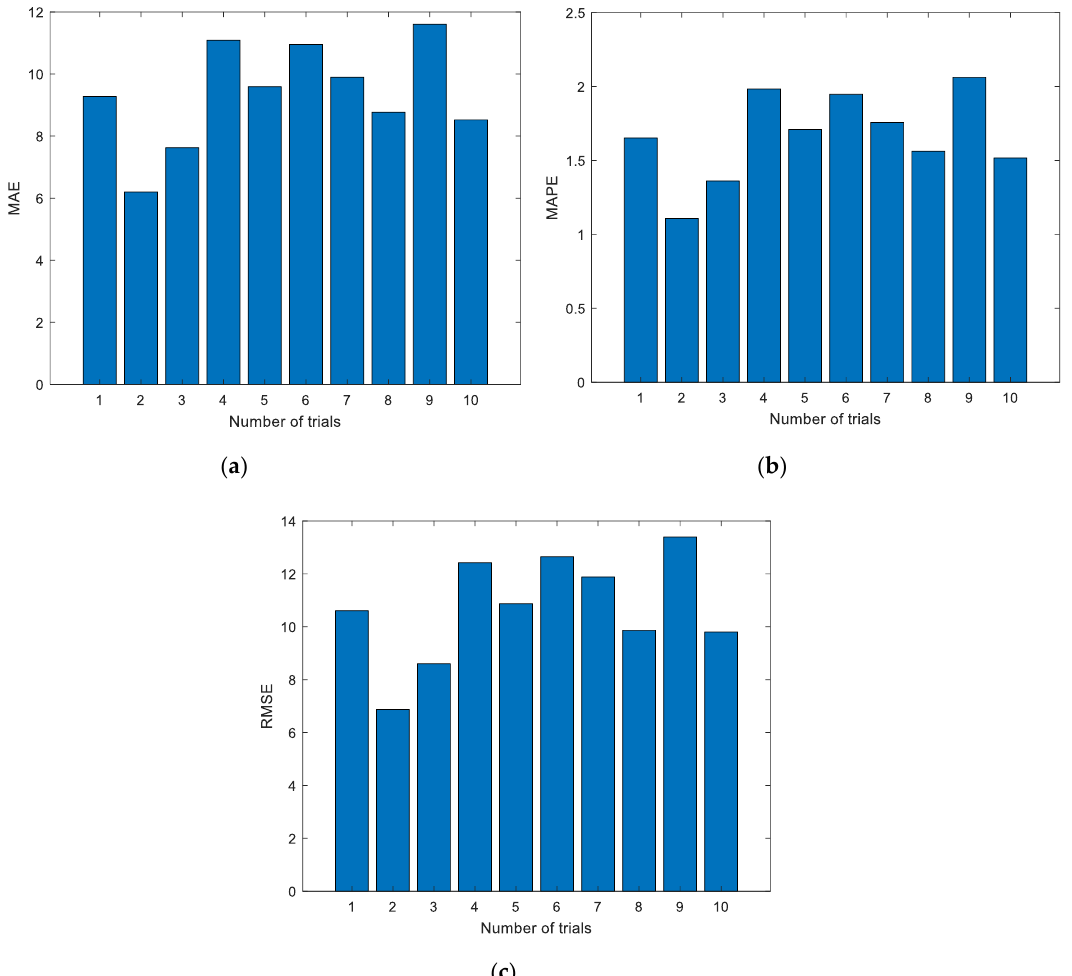
Figure 8. Evaluation metrics of ELM prediction using the second group of data. ( a ) MAE; ( b ) MAPE; ( c ) RMSE.